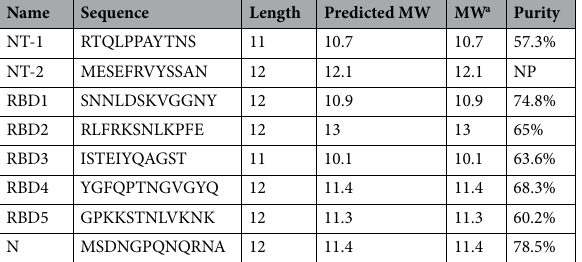
Table 4. Characteristics of MAP8 peptides. MW molecular weight provided in kDa, NP not provided. a Observed molecular weight in